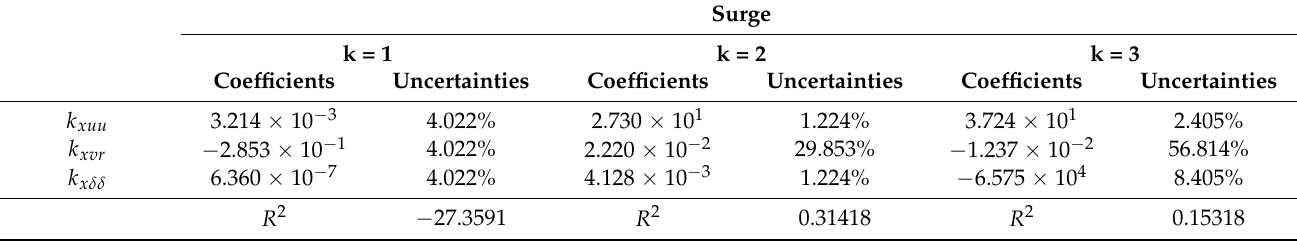
Table 5. Surge adjustment coefficients and uncertainties for tests’ data from the 30 ◦ − 30 ◦ zigzag